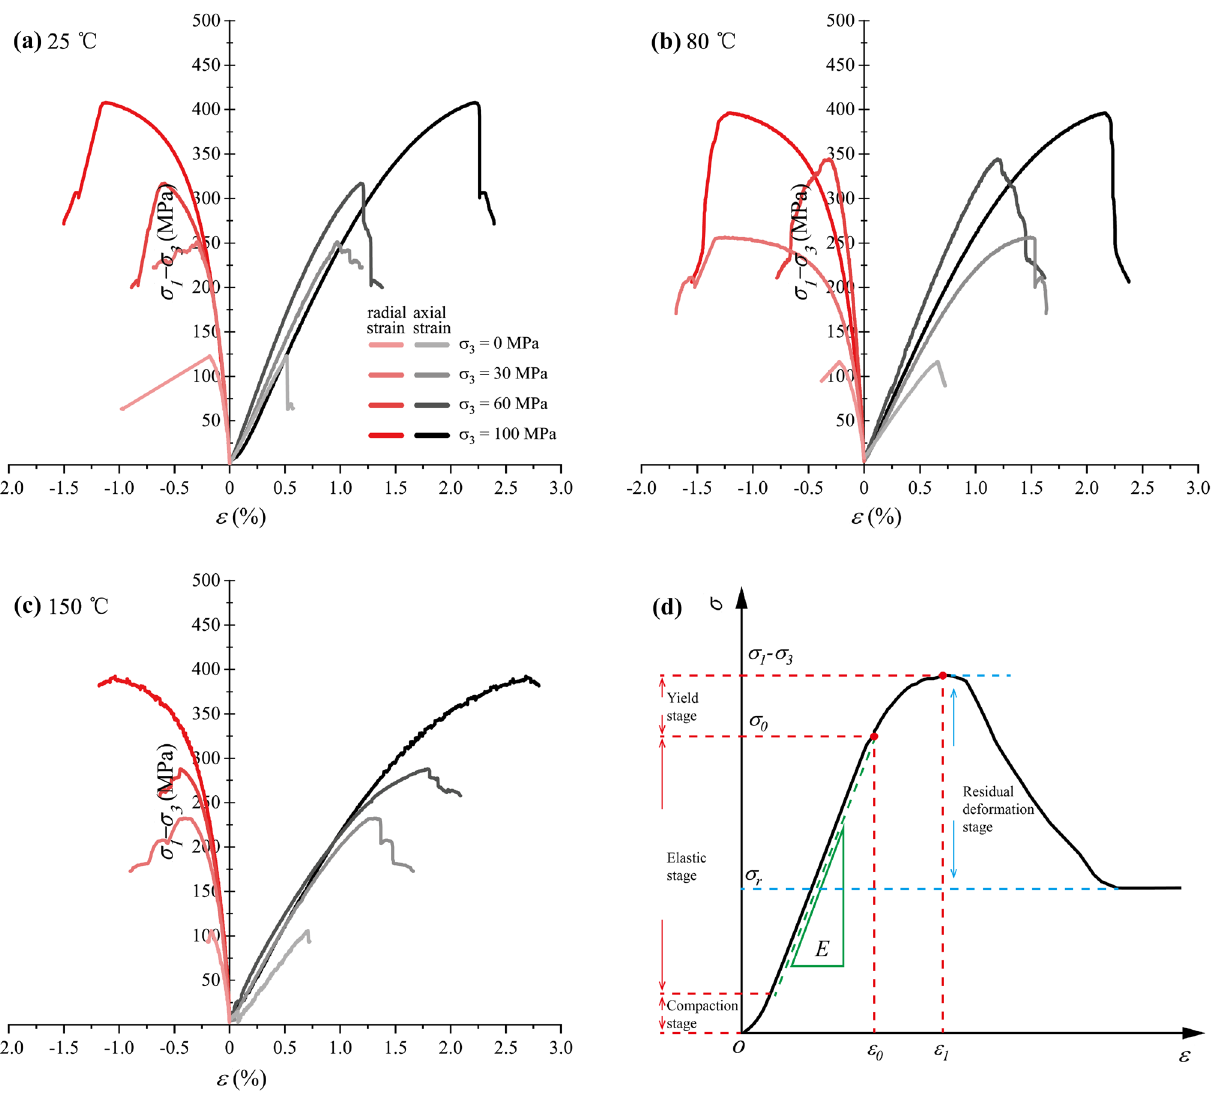
Fig. 5 Stress–strain curves for shale: a 25 °C, b 80 °C, c 150°C, d Typical stress–strain curve. 𝜎 0 : yield stress, 𝜎 1 − 𝜎 3 : peak deviatoric stress, 𝜎 r : residual stress, 𝜀 0 : yield strain, 𝜀 1 : peak strain, E : elastic